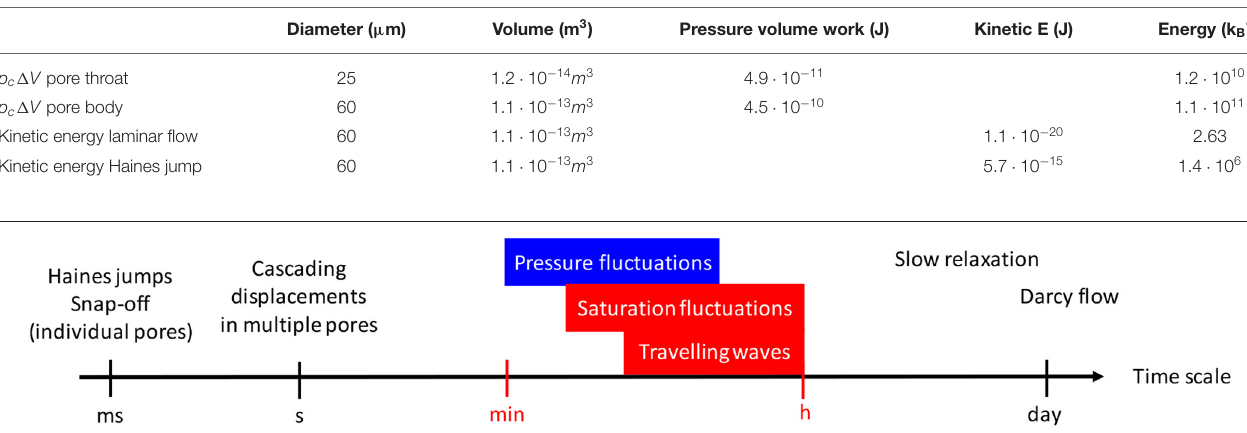
TABLE 3 | Pressure-volume work ( p c 1 V ) for model scenarios of immiscible displacement and kinetic energy for 1 ft/day flow in units of Joule (J) and thermal energy ( k B T ).